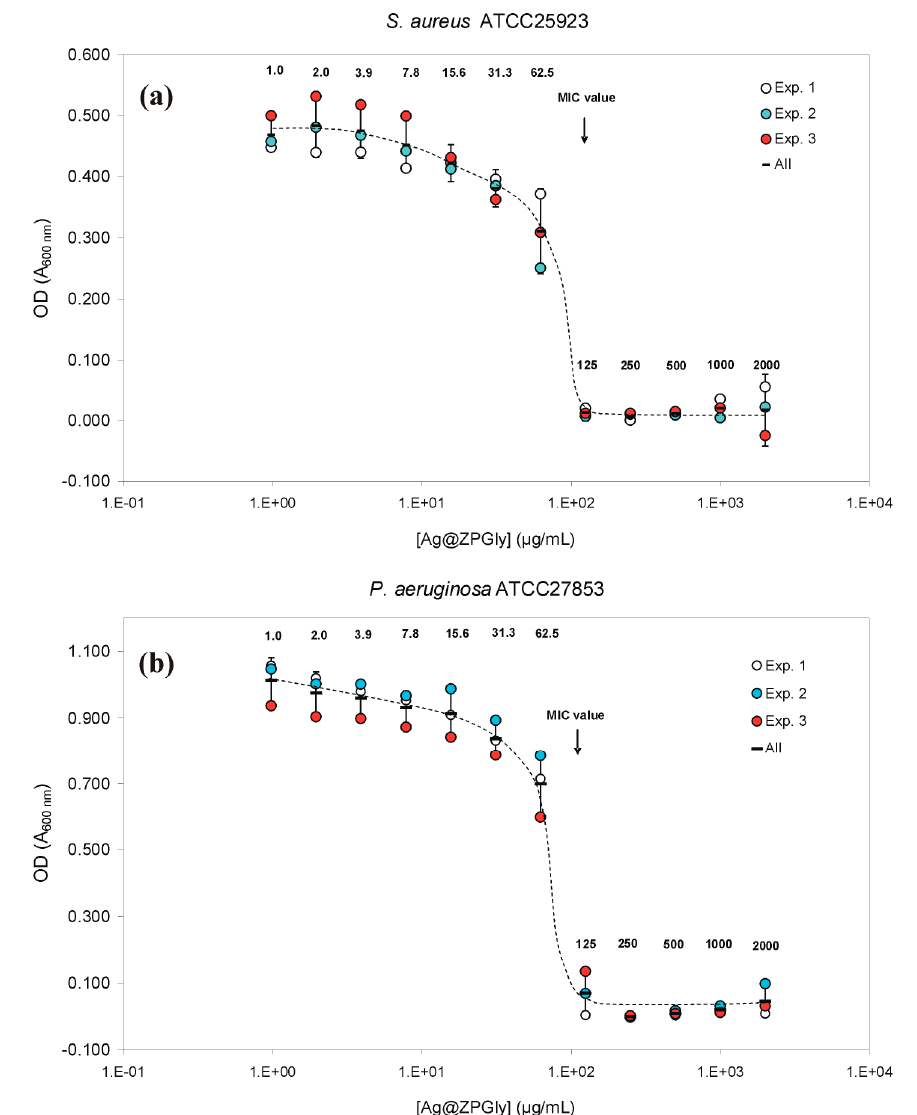
Figure 2. Bacterial inhibition curves by Ag@ZPGly: ( a ) S. aureus ATCC ® 25923 and ( b ) P. aeruginosa ATCC ® 27853. Data reported in the plot correspond to the mean OD values found for each single experiment and the mean of the 3 independent experiments ± S.D.